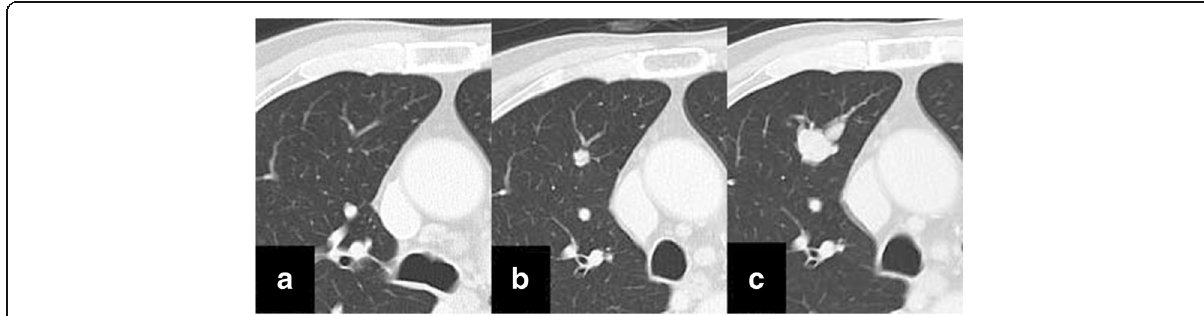
Fig. 1 Chest computed tomography. There was no tumor shadow in the lung when the resection for rectal cancer was performed ( a ). A solid nodule in the right upper lung lobe was first detected 18 months after surgery ( b ). The nodule grows in diameter 6 months later ( c )